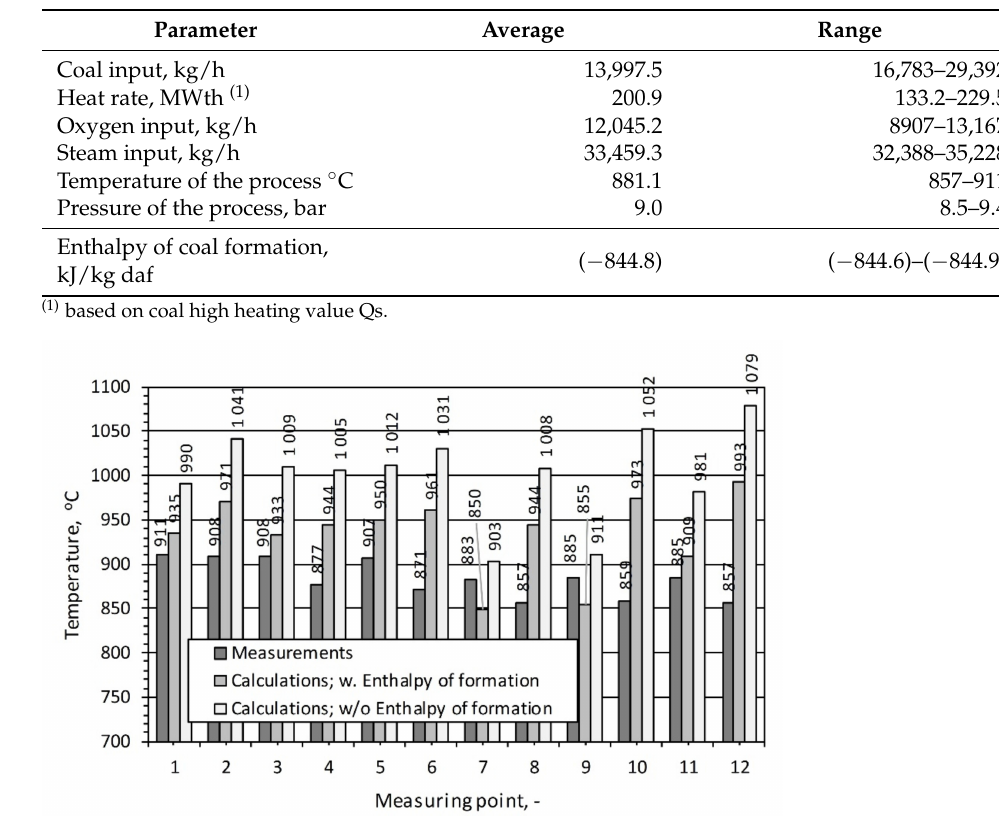
Table 6. Process parameters and results of calculation.